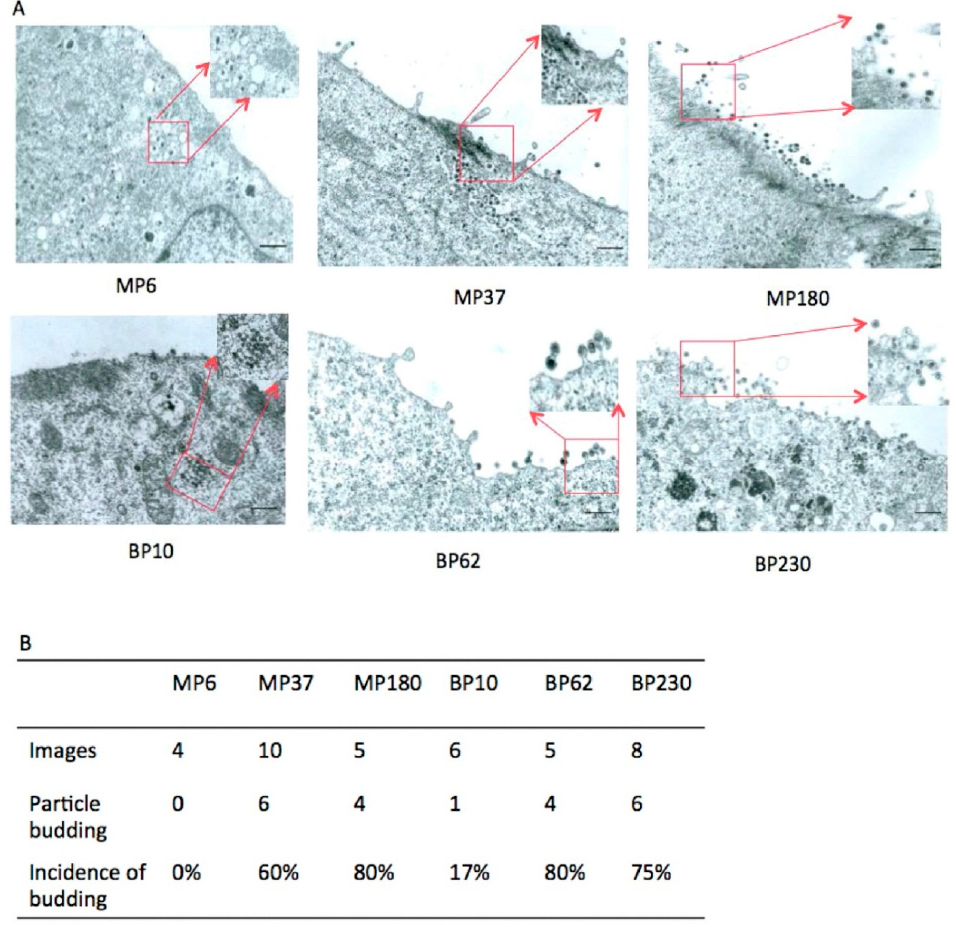
Figure 7. Enhanced budding of late-passage BFV determined by TEM. TEM was performed to directly examine particle release of BFV from different passages. ( A ) BFV-infected MDBK and BHK-21 cells from the indicated passages (BFV-infected MDBK cells: MP6, MP37, and MP180; BFV-infected BHK-21 cells: BP10, BP62, and BP230) were washed three times, fixed for 10 min at room temperature, and processed as described previously [38]. Some views with BFV capsids indicated by red boxes are magnified. Black bars represent 4 μ m. ( B ) Quantification of BFV budding from different passages. Different TEM images were used to quantify budding. Only cells with intracellular, clearly visible BFV capsids were scored for the presence of budding events at the cell surface.